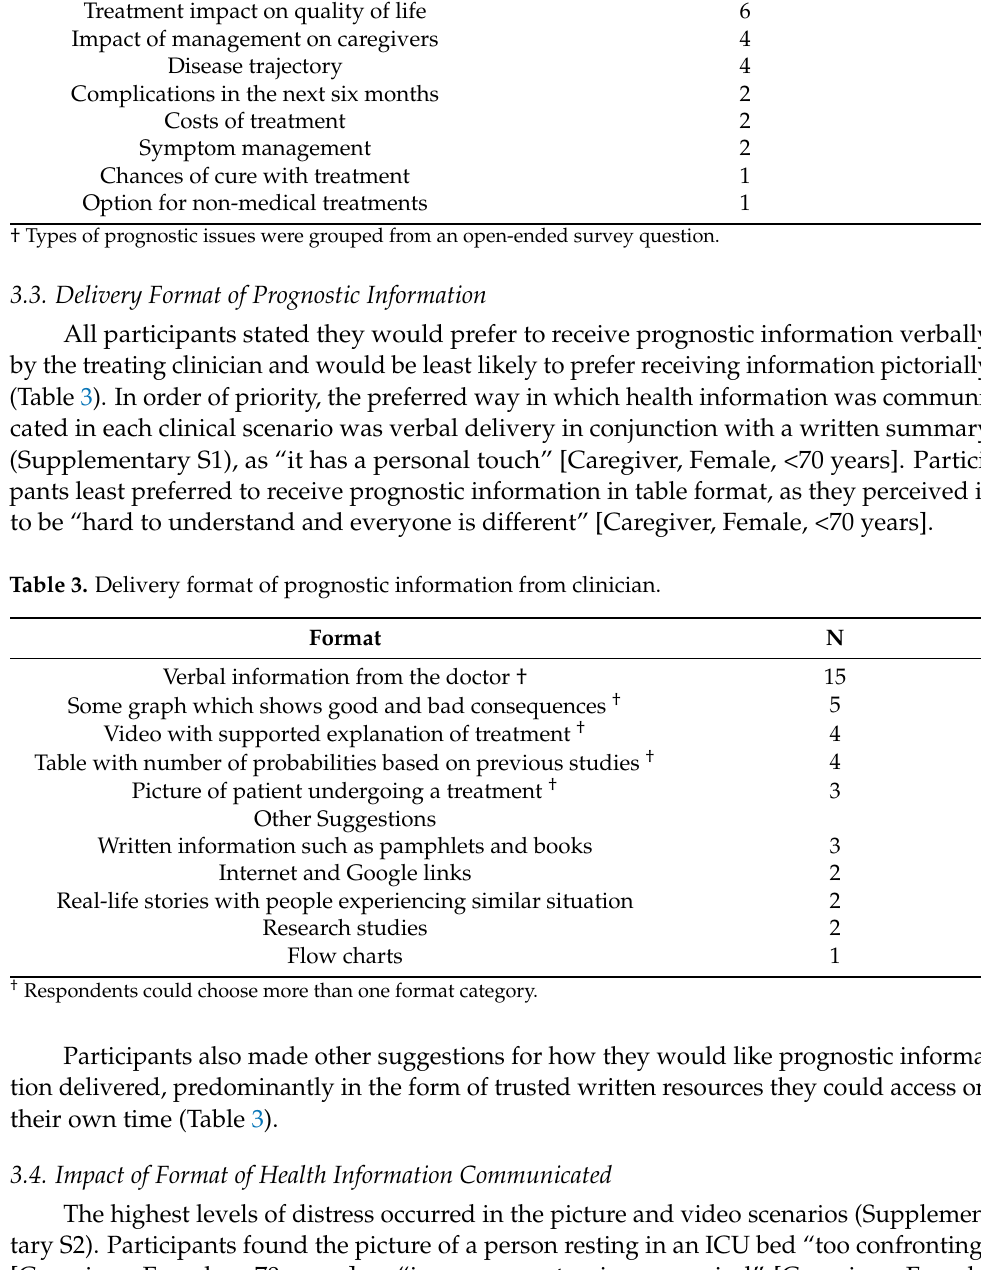
Table with number of probabilities based on previous studies